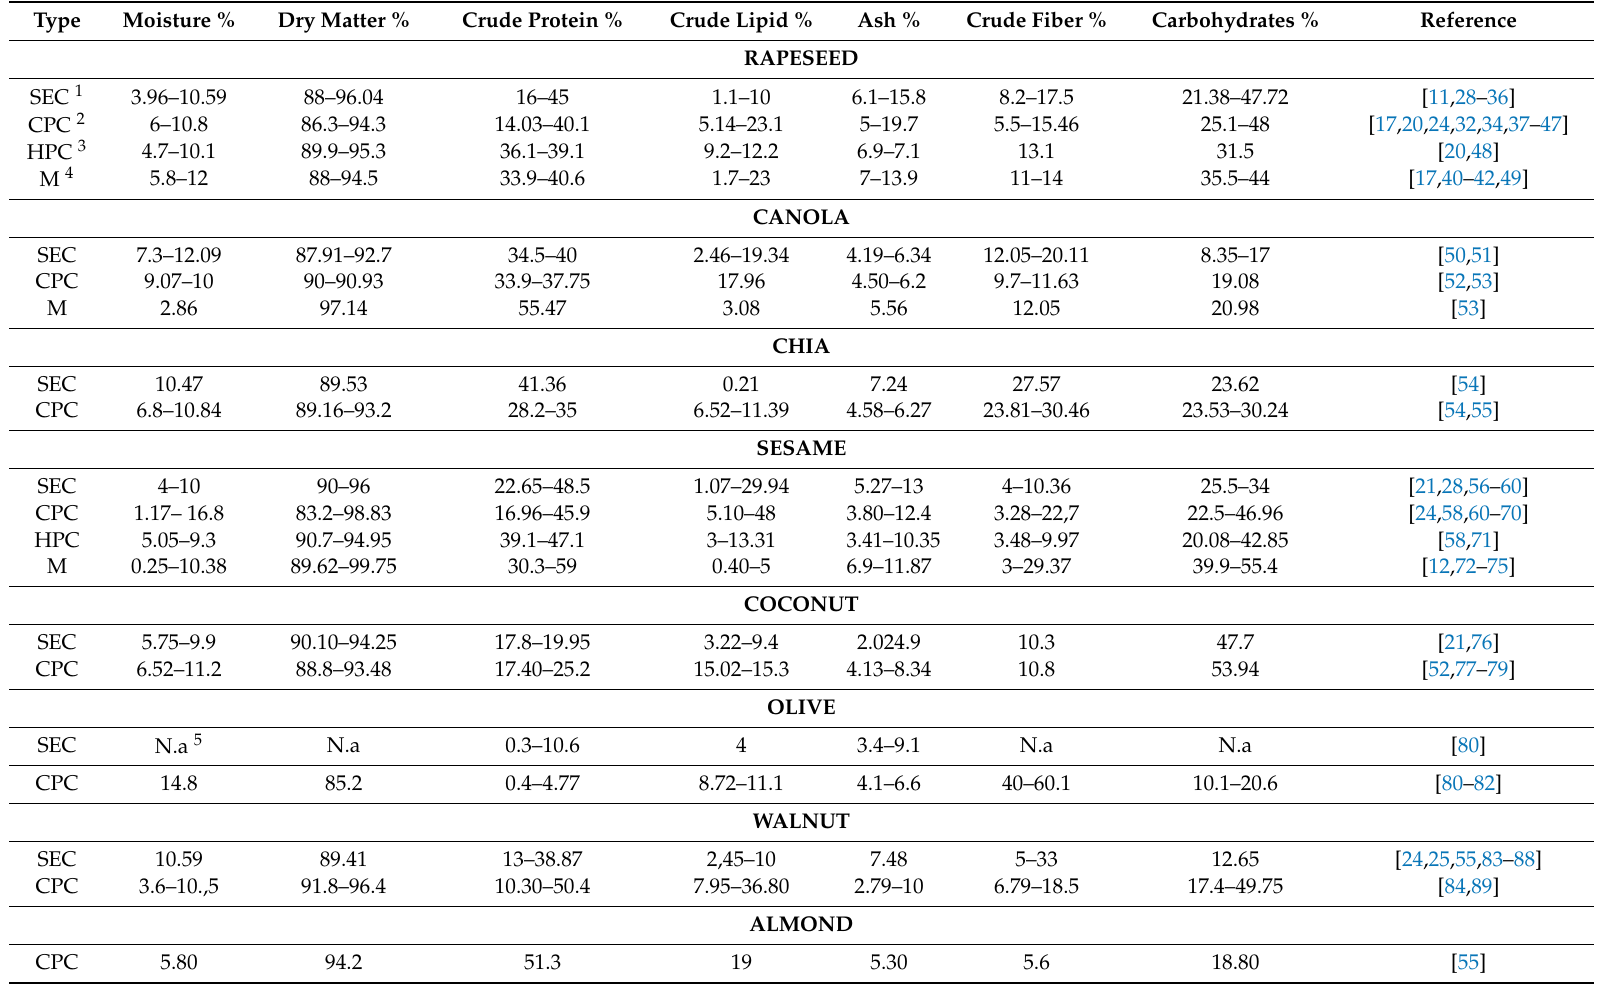
Table 1. Chemical composition of oilcake / meals obtained from di ff erent methods of